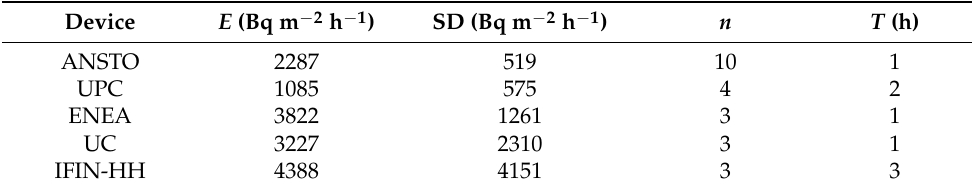
Table 5. Mean radon flux E obtained from the average of n number of measurements carried out in the high radon flux area campaign considering a time period T in the linear fit and the standard deviation SD of the mean.